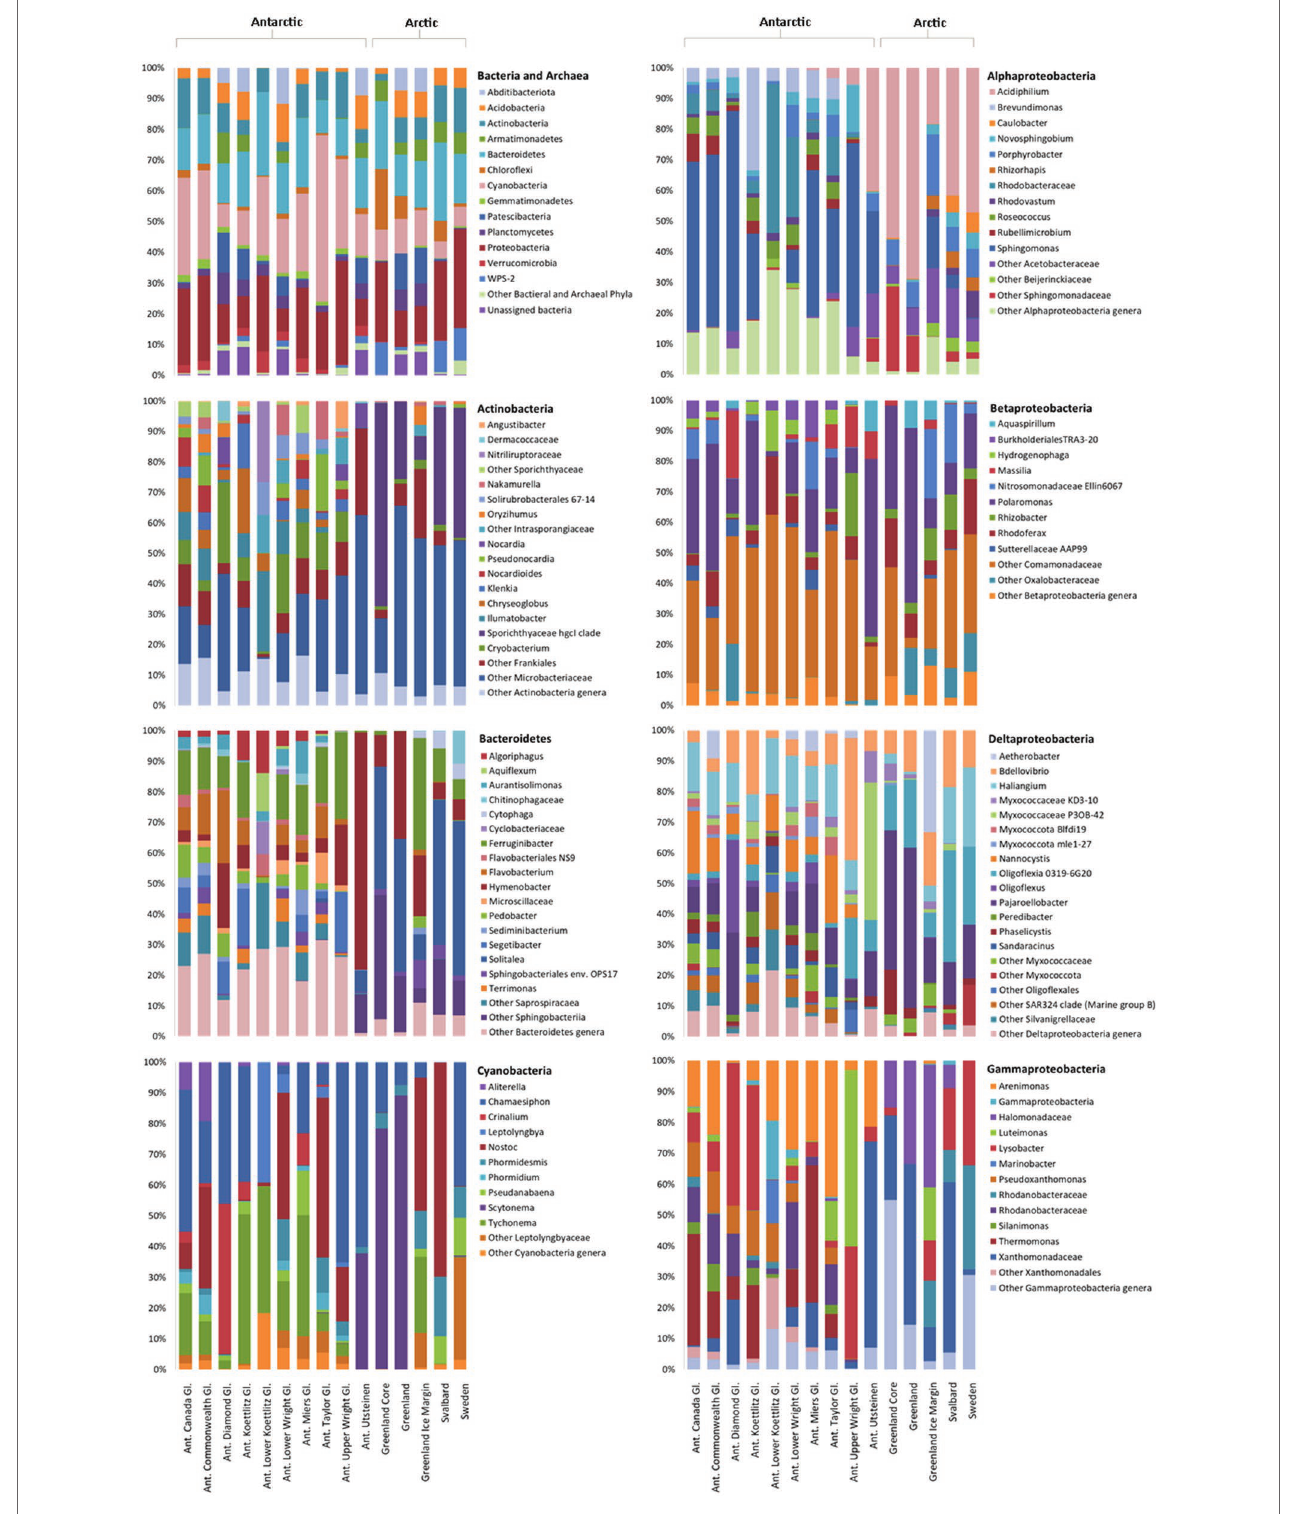
FIGURE 2 | Relative abundance of bacteria in Arctic and Antarctic cryoconite, averaged by glacier. Top left: Bacterial phyla. Phyla contributing to <1% of the total abundance are grouped as “Other.” Remaining panels: Relative abundance of genera within the top four most abundant phyla. Proteobacteria have been divided into alpha-, beta-, delta-, and gammaproteobacteria. Genera contributing to <1% of the total abundance are grouped as “Other.” Where a genus was unknown, lowest rank known is shown. Taxa were assigned according to the SILVA database. “Ant. Gl.” denotes Antarctic